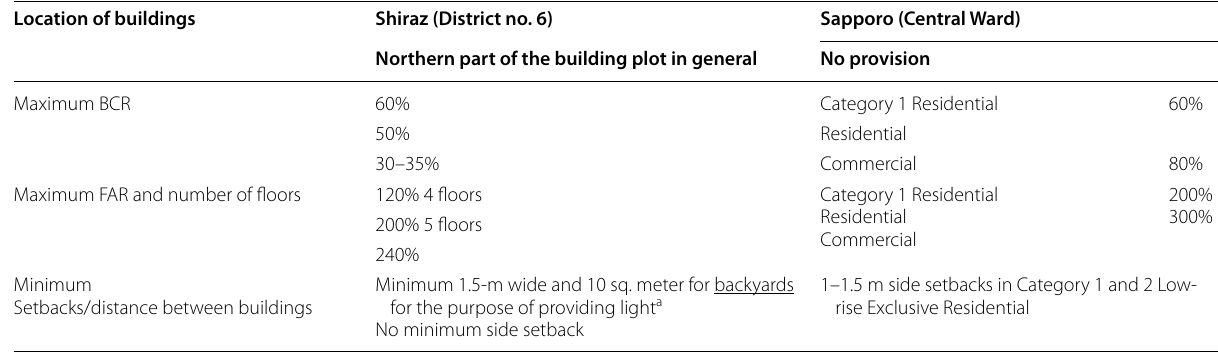
Table 2 Demographic characteristics of the